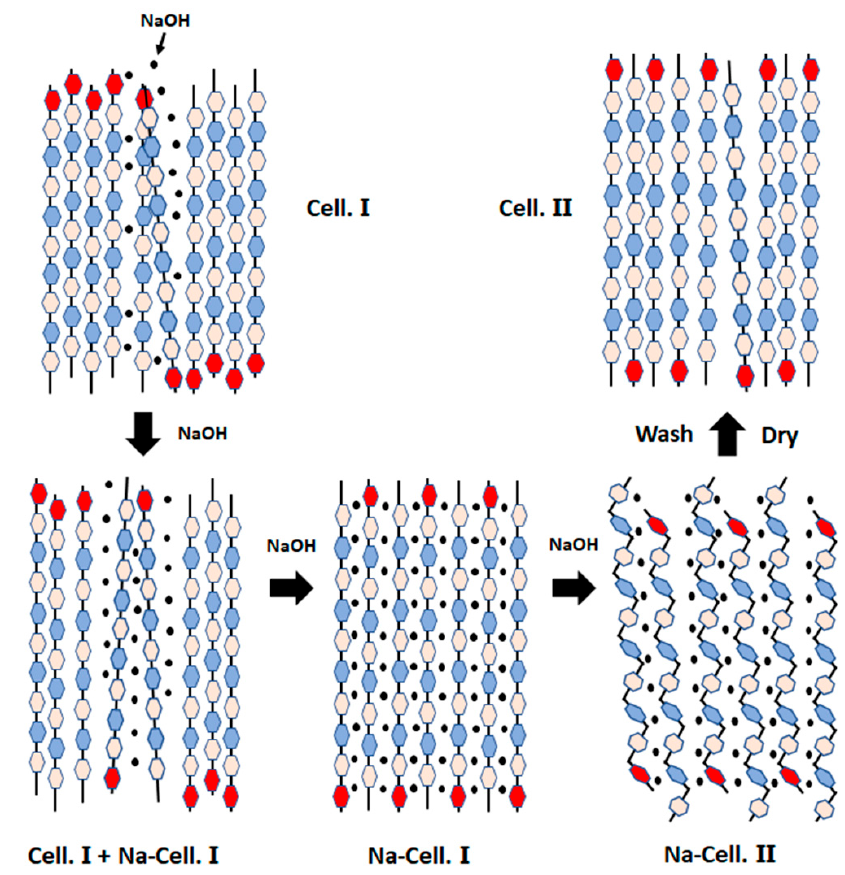
Figure 3. Schematic presentation of parallel-packed cellulose I converting to antiparallel-packed cellulose II during mercerization. Reaction scheme adapted from [75].